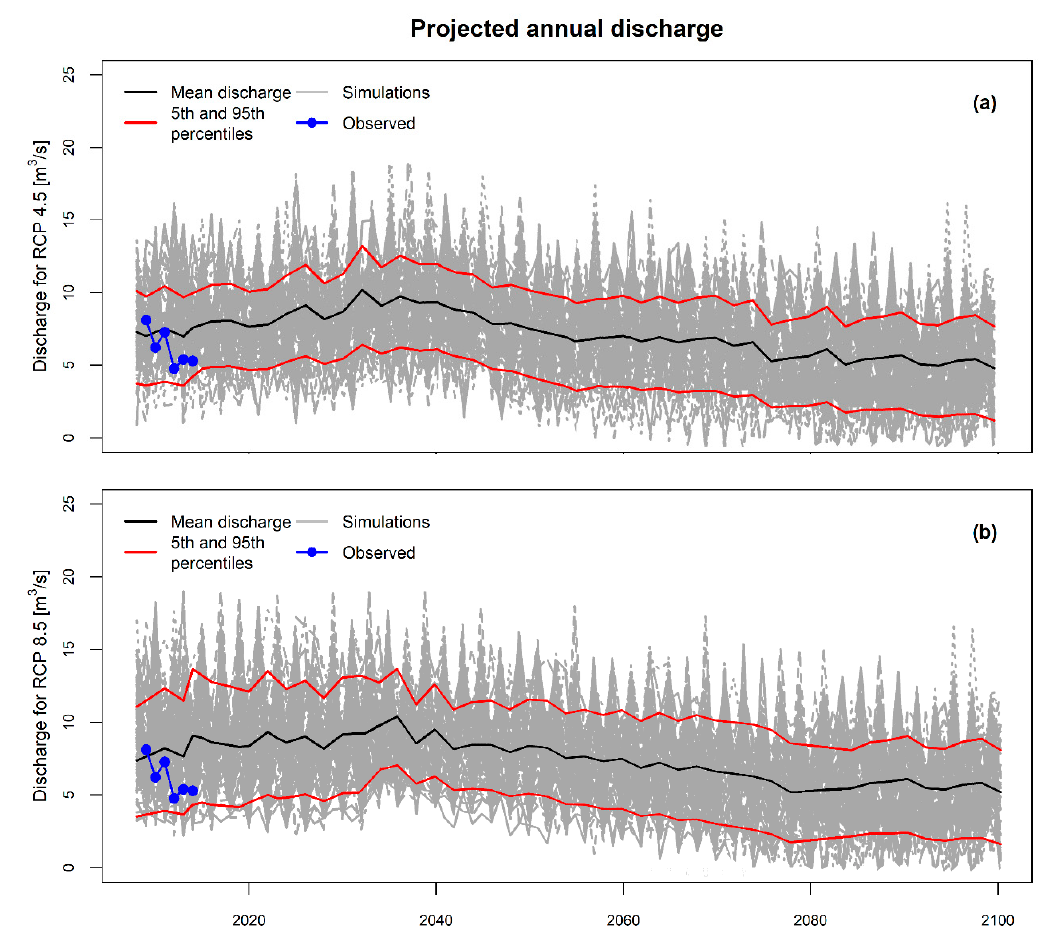
Figure 7. Results of the 70 simulations for two emission scenarios. ( a ) RCP 4.5 scenario; ( b ) RCP 8.5 scenario. The confidence intervals associated with the 5th and 95th percentiles are indicated in red, along with the mean of the discharges simulated by the 70 GCM simulations under the two scenarios (in black). Blue dots indicate the observed mean annual discharges (2008–2014).